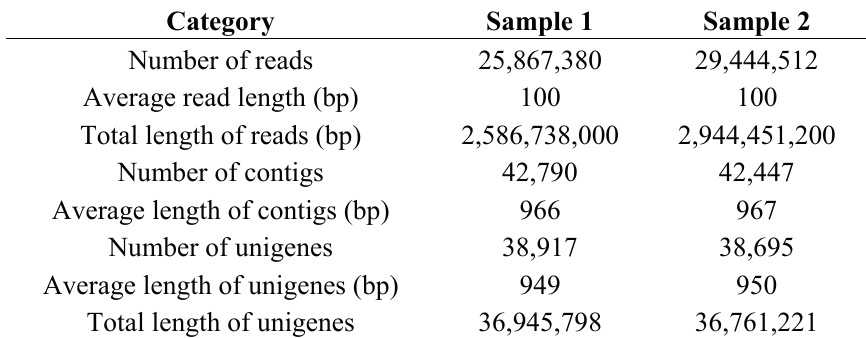
Table 1. Summary of the litchi pericarp transcriptome.